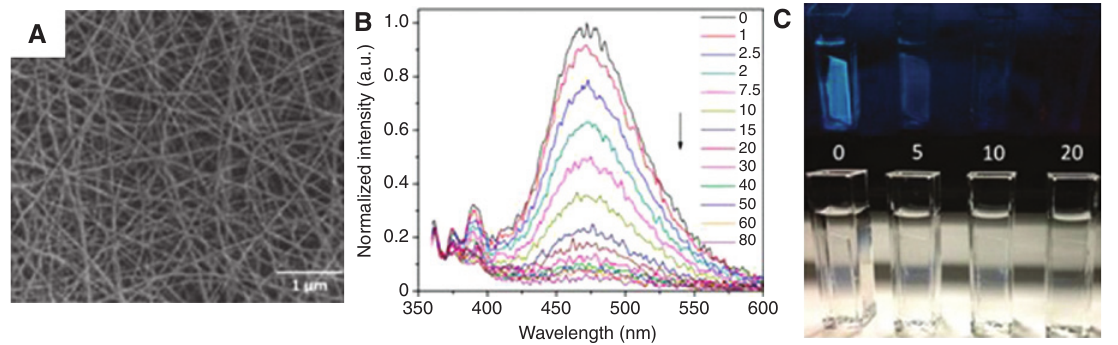
Figure 22: (A) SEM image of the Py-PES nanofibrous film using 4% PES concentration at a fixed Py concentration of 0.1 m and DMF/THF ratio of 4:6; (C) concentration-dependent fluorescence quenching of Py-PES nanofiber film upon the addition of different concentrations ( μ m) of TNT in DI water. (B) Photographs of Py-PES fluorescent nanofiber films in cuvette under UV light (254 nm, upper panel) and visible light (bottom panel) in the presence of various TNT concentrations (0, 5, 10, and 20 μ m). For details, see Ref. [98]; reprinted with permission from American Chemical Society.